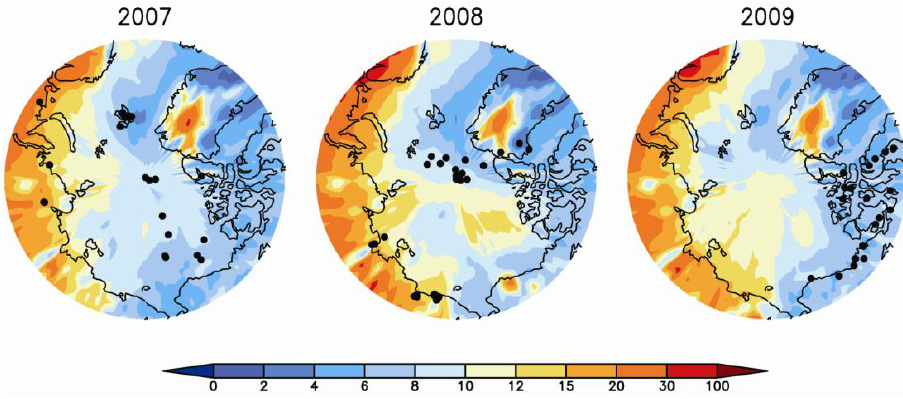
Fig. 2. Simulated sBC in and around the Arctic Ocean in spring 2007–2009. Black circles indicate the measurement sites for the corresponding years.